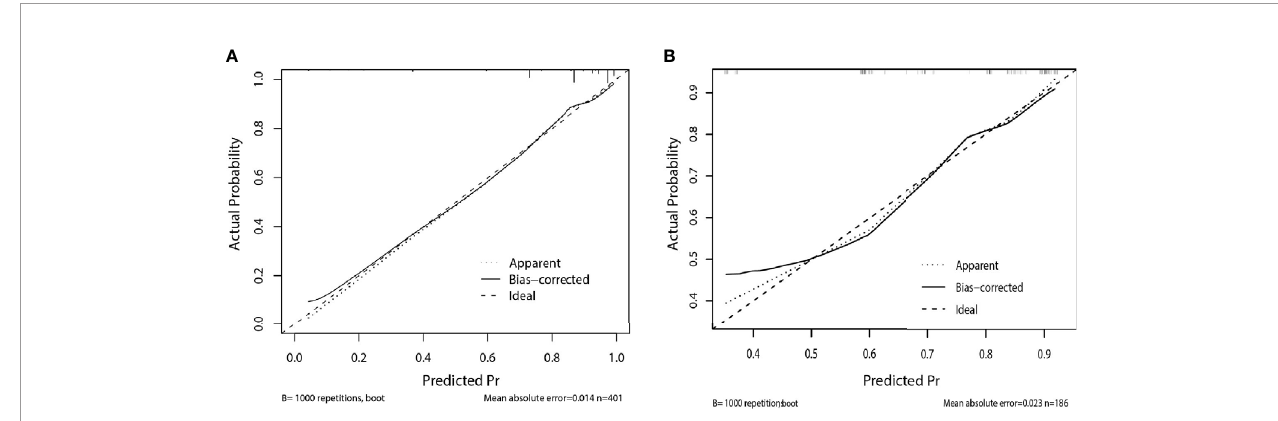
FIGURE 3 | Calibration curve of the nomogram for predicting upgrade to breast cancer: (A) in the training set, (B) in the validation set. The solid line represents the ideal reference line that predicted ADH upgrade corresponds to the actual outcome, the short-dashed line represents the apparent prediction of nomogram, and the long-dashed line represents the ideal estimation. The prediction performance of the nomogram in training and validation set show closely to observed rates.